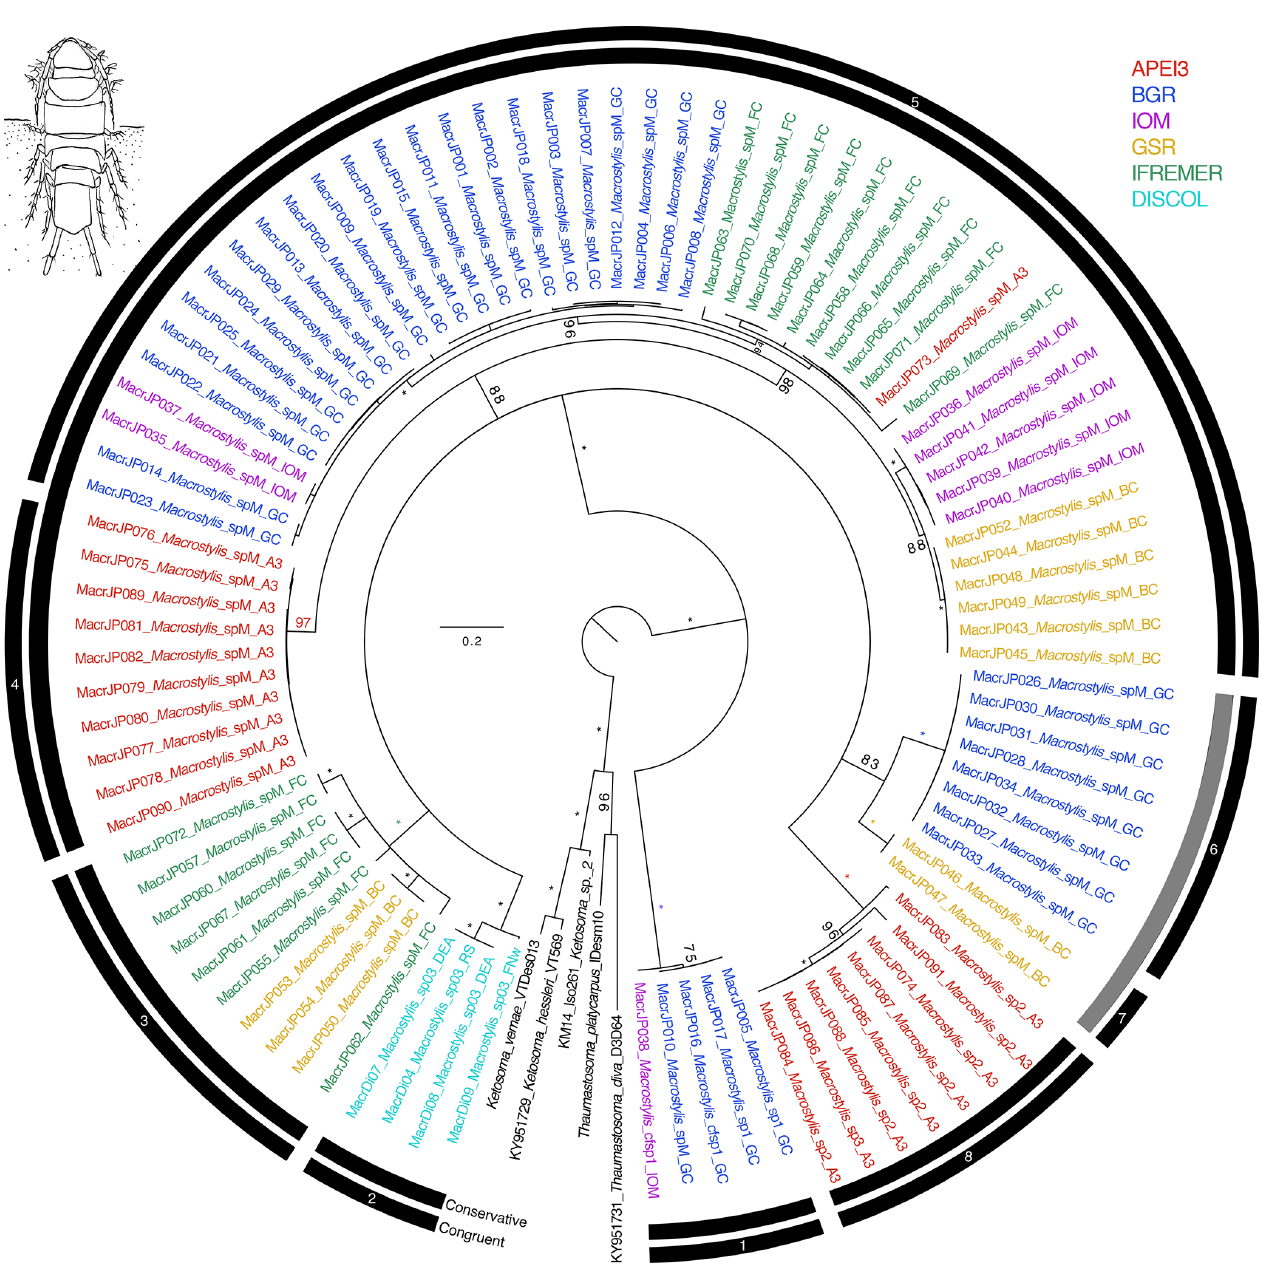
Figure 6. Phylogenetic tree of all macrostylid samples based on 16S and COI sequences for 94 specimens. Colors indicate collection location with black indicating outgroups. All unsupported branches were collapsed, and bootstrap support is indicated with asterisks indicating 100% bootstrap support. The outer two bars summarize the results of the species delimitation analyses which included morphological determination, VSEARCH for individual genes, ABGD for individual genes, and PTP and mPTP for both individual genes and the concatenated datasets. The conservative bar indicates that all SD analyses supported that split, while the congruent bar indicates that the majority of SD analyses showed that split. Numbers on congruent bars are arbitrary and are provided to allow a way to refer to specific supported